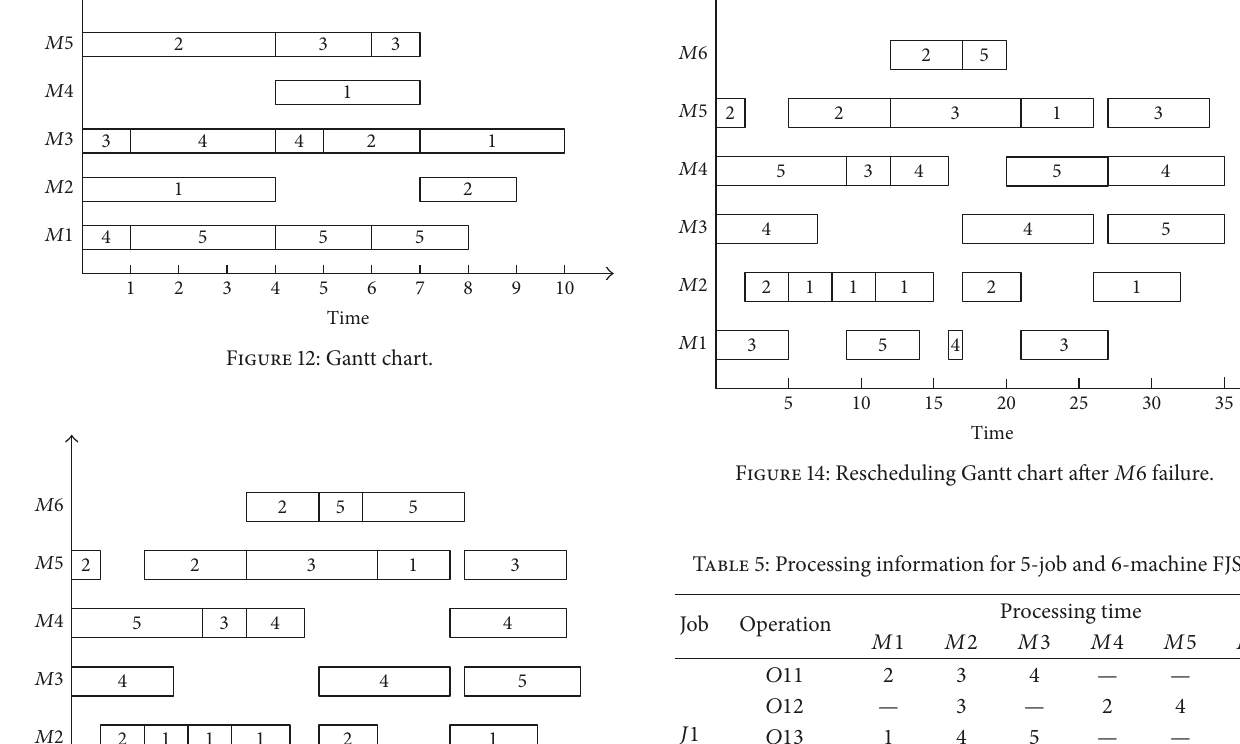
Table 5: Processing information for 5-job and 6-machine FJSP.